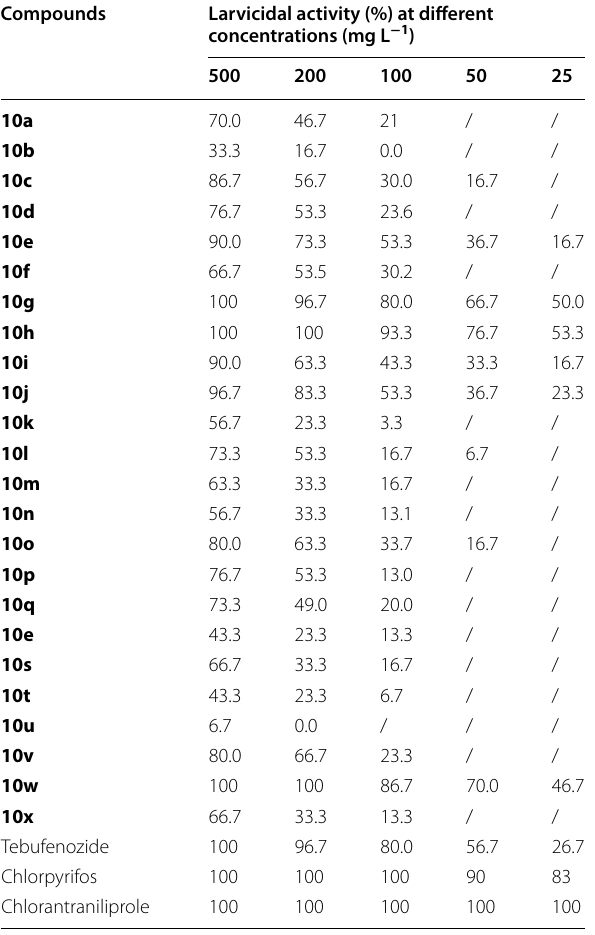
Table 2 Larvicidal activity of compounds (10a–10s) against Plutella xylostella Compounds